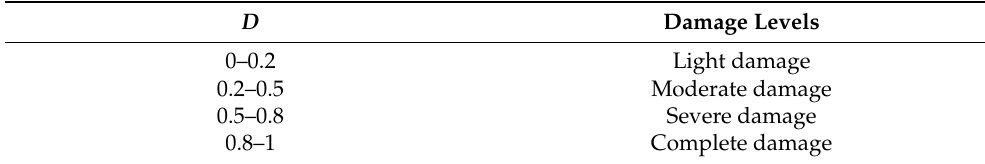
Table 13. Threshold value for different damage levels of the tunnel.